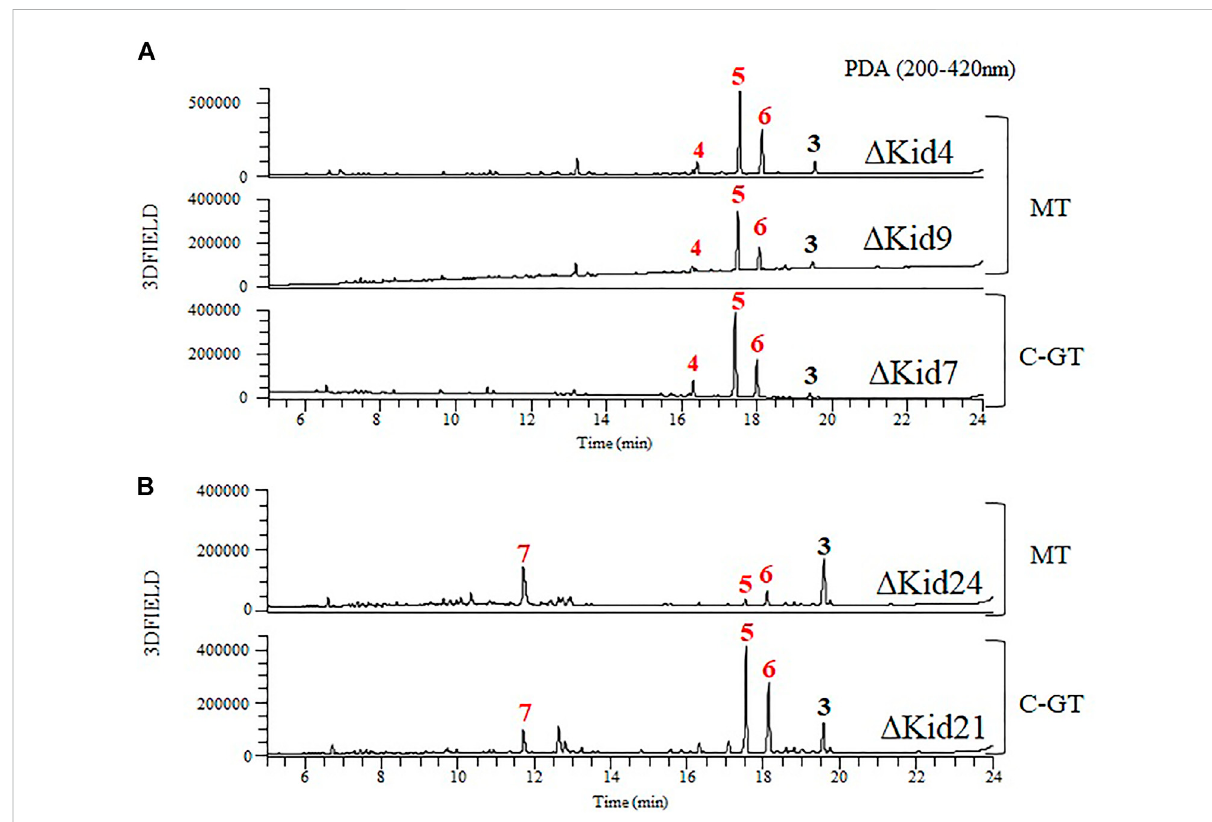
FIGURE 7 Comparative HPLC analysis of the products of the methyltransferase (MT) mutants and C-GT mutants. (A) Δ Kid4 (upper), Δ Kid9 (middle), and Δ Kid7 (bottom). (B) Δ Kid24 (upper) and Δ Kid21